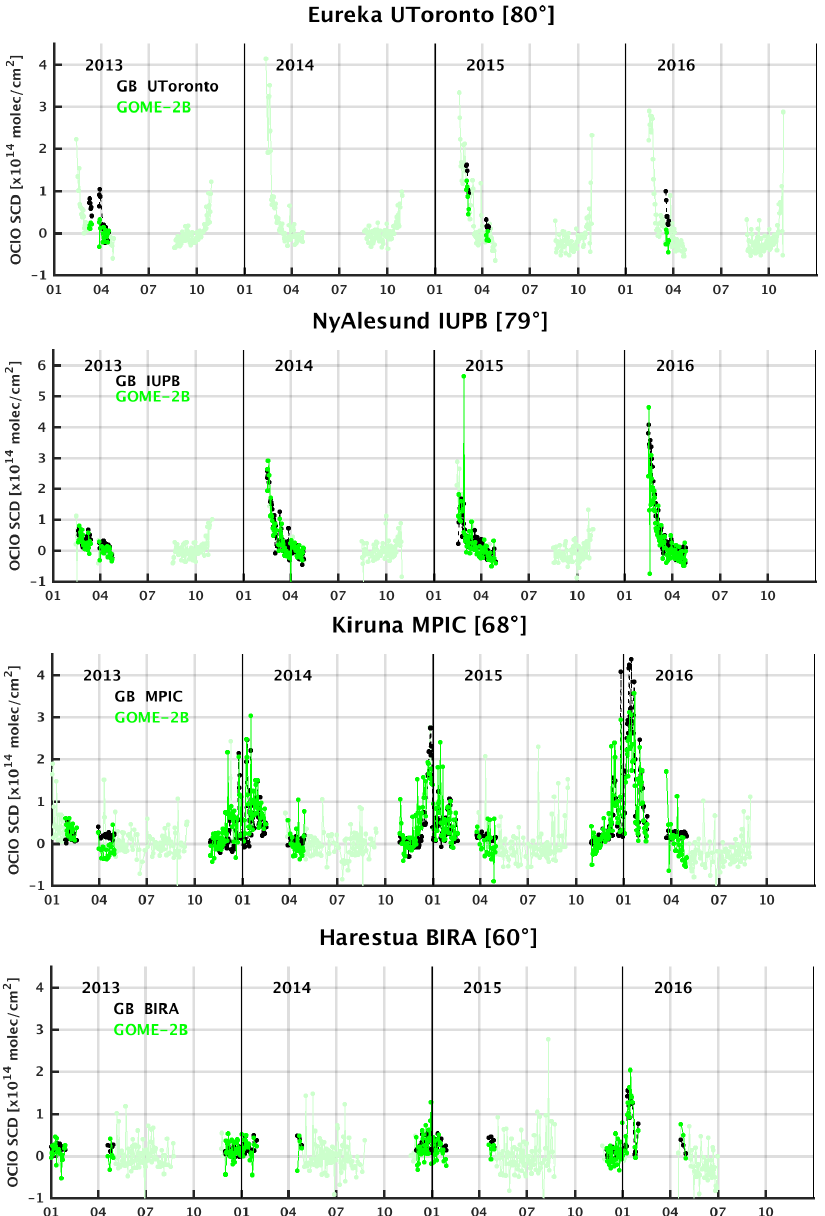
Figure 14. Time series of GOME-2B (green) OClO daily mean slant column data co-located with ground-based (black) measurements performed at each Arctic station. The lighter transparent green color is used for GOME-2B when there are no ground-based